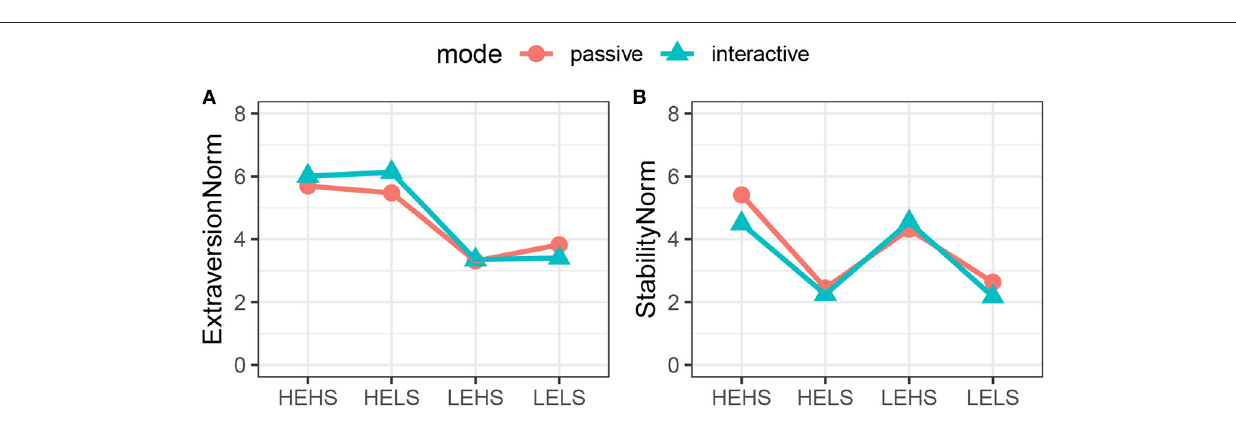
FIGURE 10 | Comparing the passive with the interactive mode of interaction. Extraversion (A) and Stability (B)